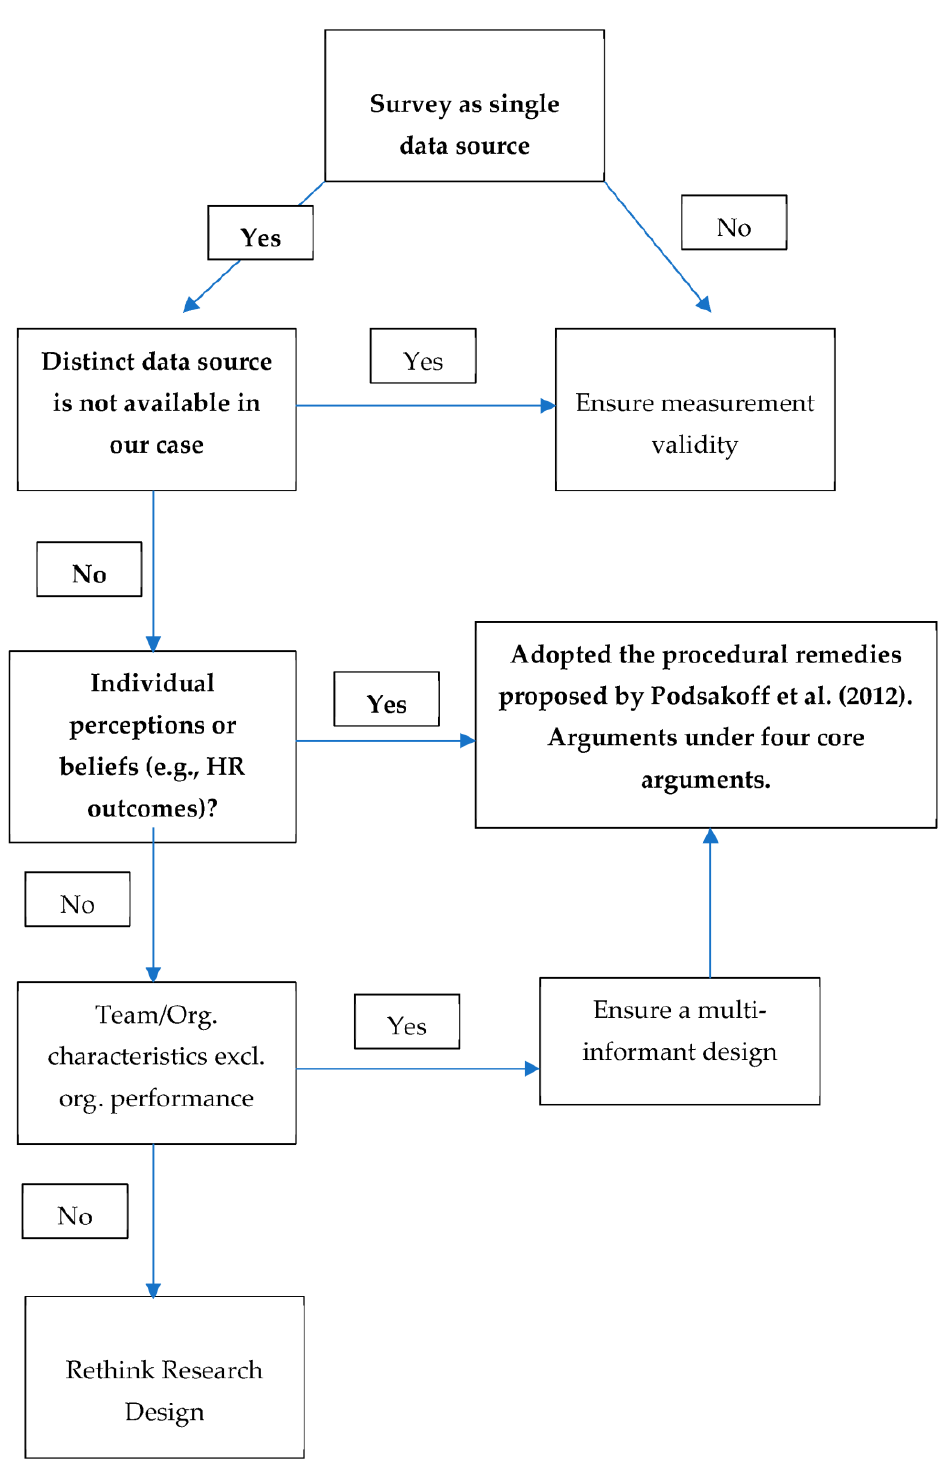
Figure A1. Flow Chart for Tackling the Common Source Bias. Source: George et al. [22].